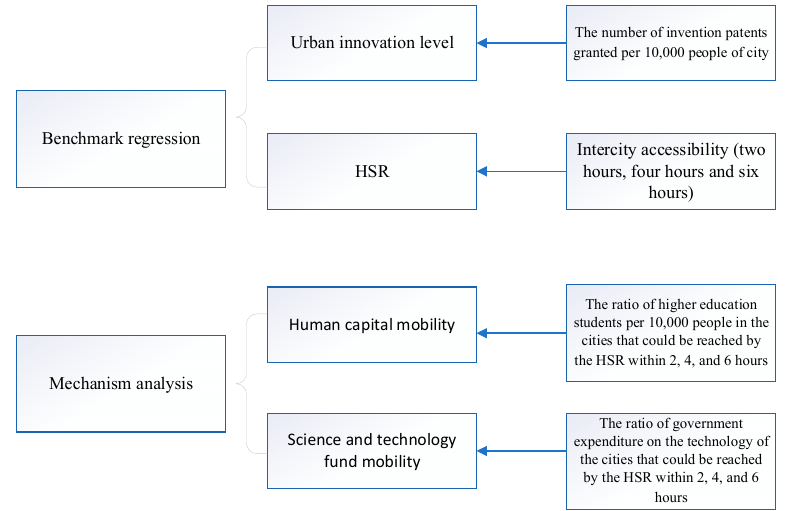
Figure 2. Research steps and main variables.